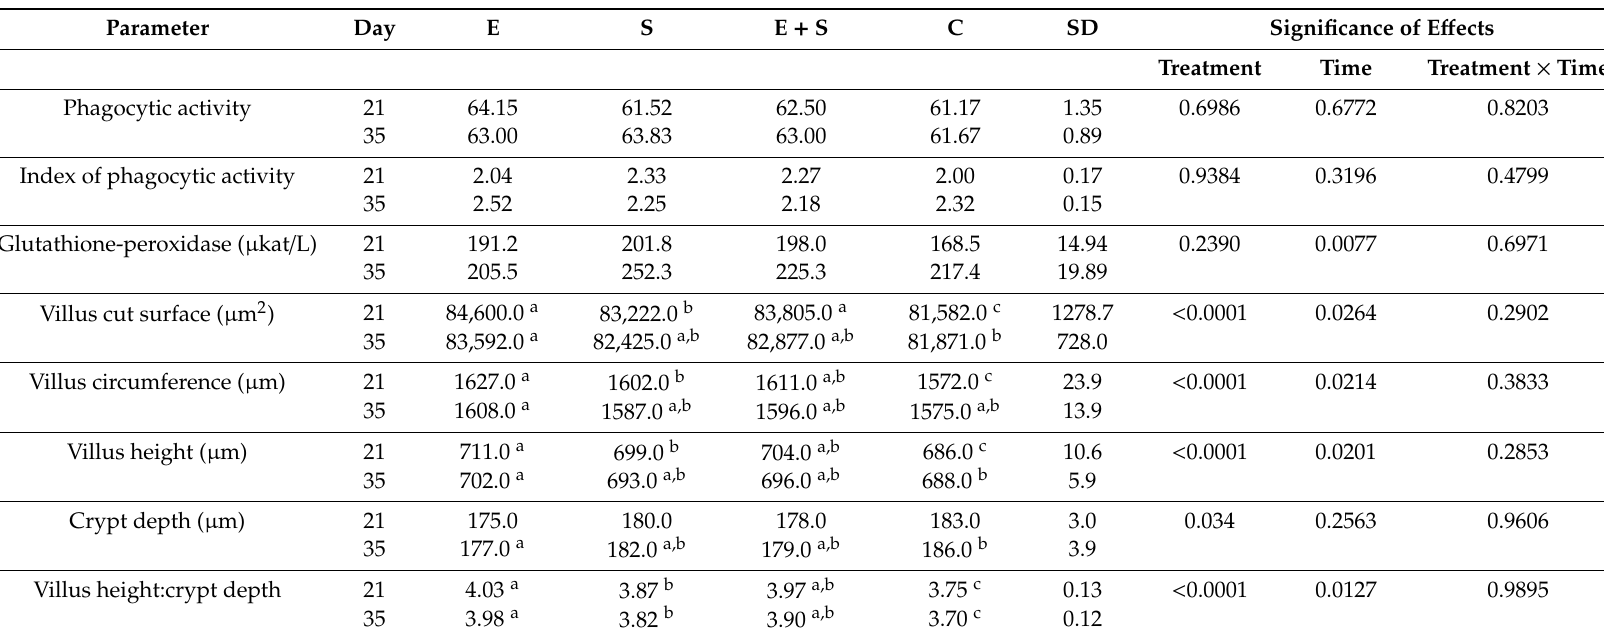
Table 6. The e ff ect of E, S, and E + S application on phagocytic activity of leukocytes, glutathione-peroxidase activity, and jejumal morphometry of rabbits.